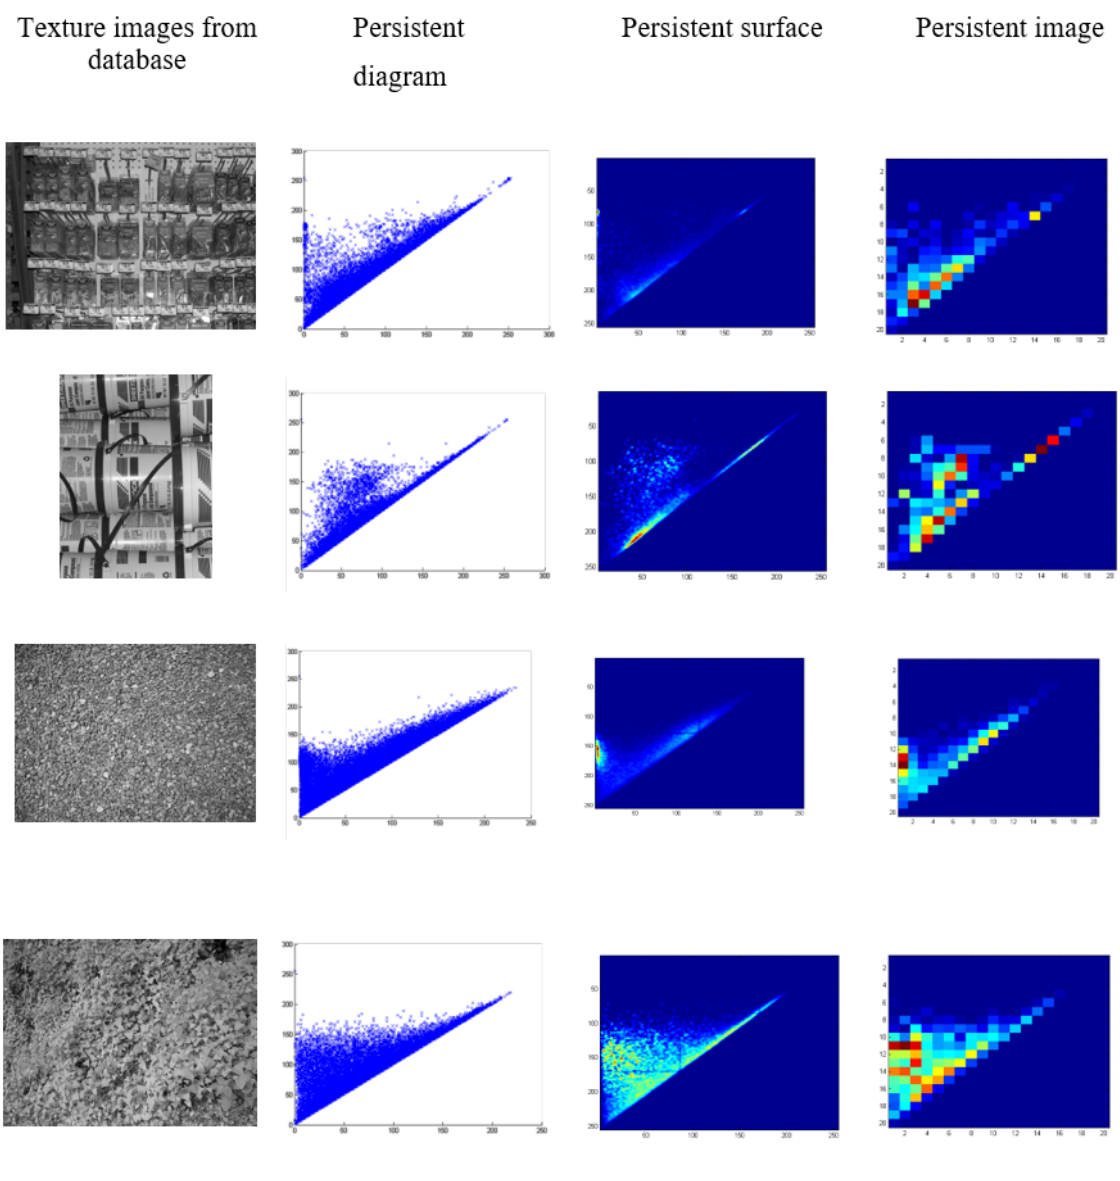
Figure 2: Examples of persistent images. From top to bottom: texture images from a standard database for 4 different classes. From left to right: texture, PD for the component of β 0 , persistent surface, persistent image (resolution 20 × 20, σ = 1